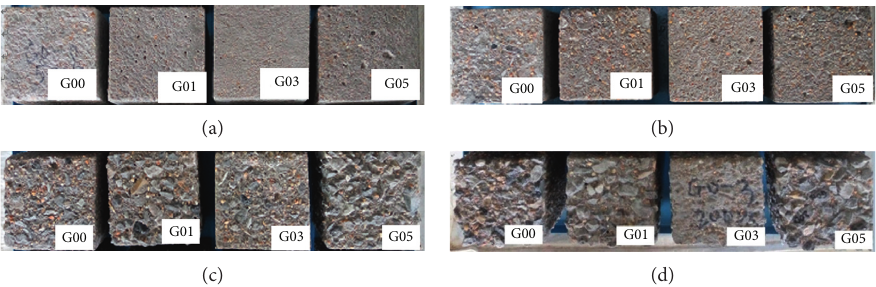
Figure 3: Macroscopic failure characteristics of GO concrete under different salt-freezing cycles. (a) 50 salt-freezing cycles. (b) 100 salt- freezing cycles. (c) 150 salt-freezing cycles. (d) 200 salt-freezing